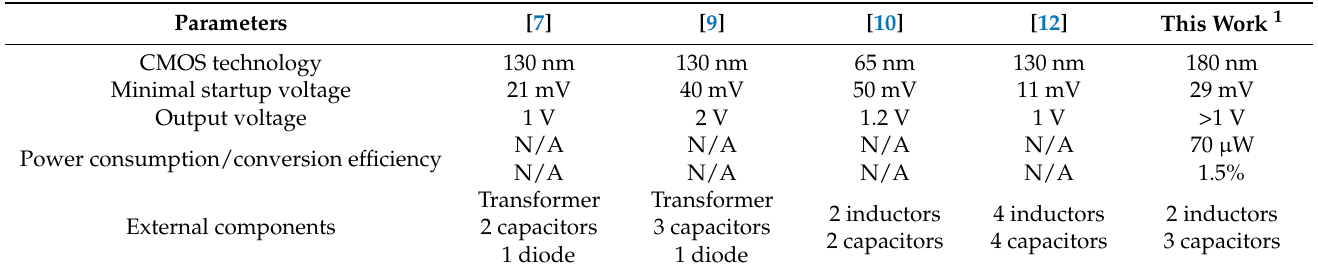
Table 3. Comparison of